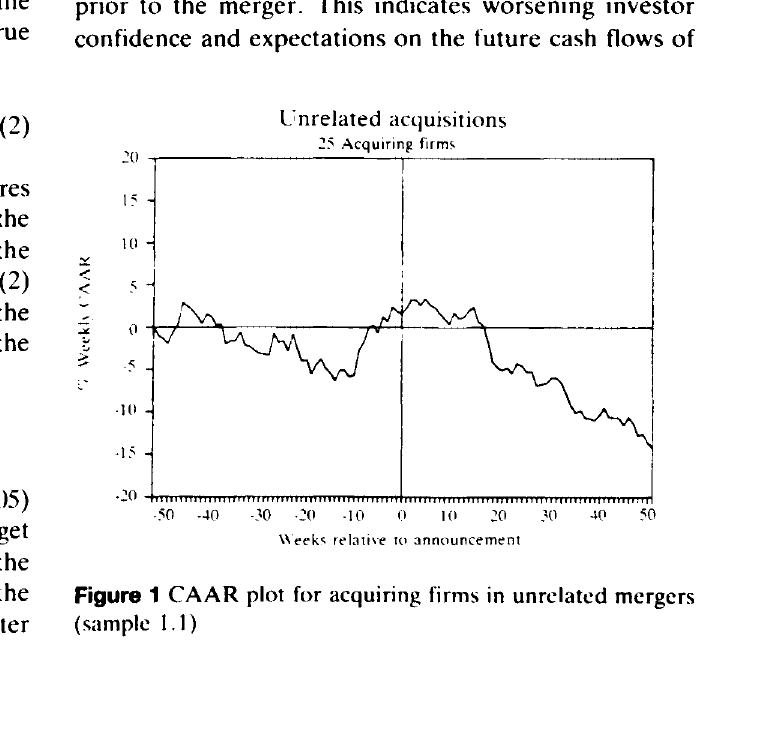
Figure 1 CAAR plot for acquiring firms in unrelated